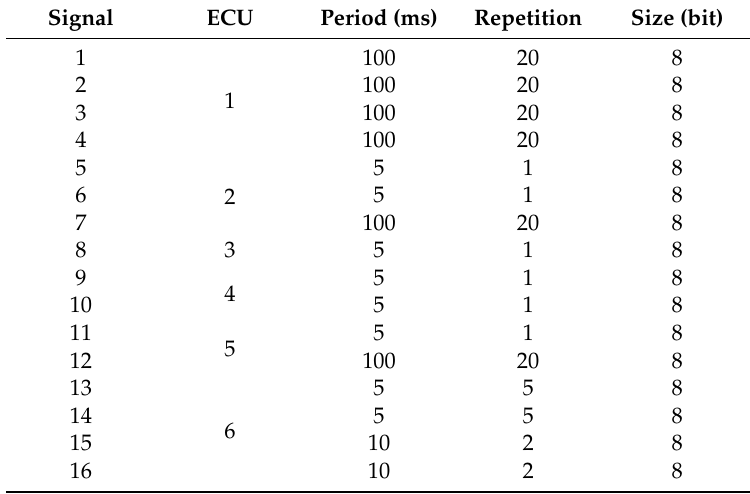
Table 4. SAE benchmark